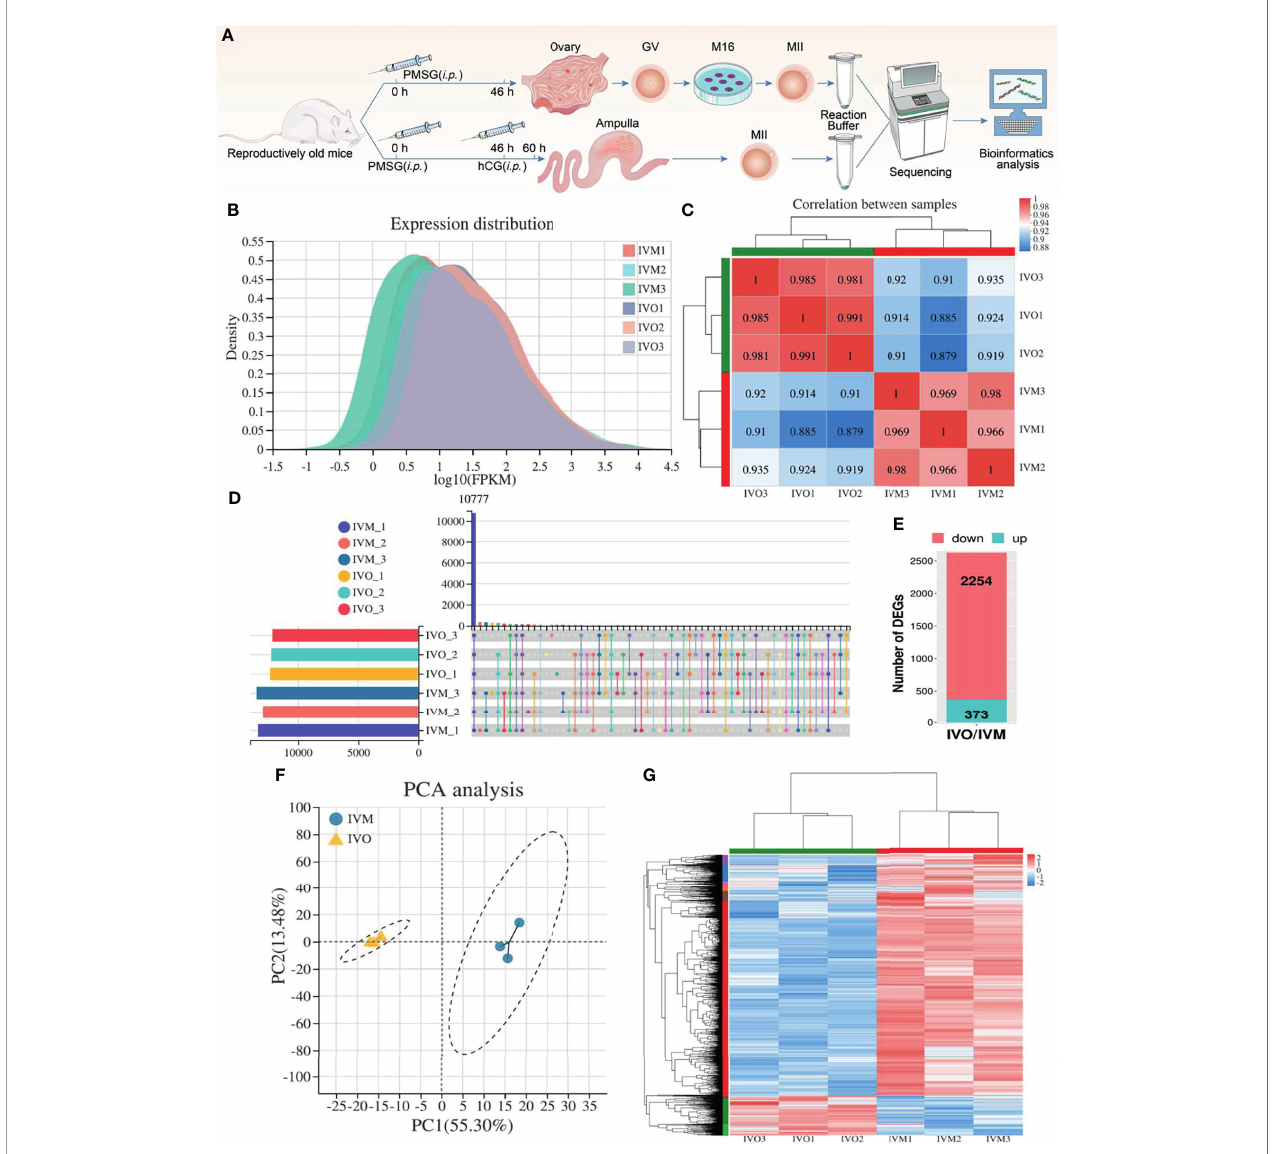
FIGURE 1 | DEG analysis between IVO and IVM groups. (A) A schematic showing experimental design and time points. (B) Gene expression density distribution in the IVO and IVM groups. (C) Correlation analysis between the IVM and IVO groups. The degree of correlation is represented by different colors. (D) An UpSet plot summarizing the genes detected in the six groups. (E) A stacked column showing the numbers of DEGs in the IVO group compared with the IVM group. (F) PCA of gene expression pro fi les in oocytes between the IVM group (blue dots) and the IVO group (yellow triangles). (G) Heatmap showing DEGs; the red rows represent high expression levels and blue rows represent low expression levels. Each column represents an independent